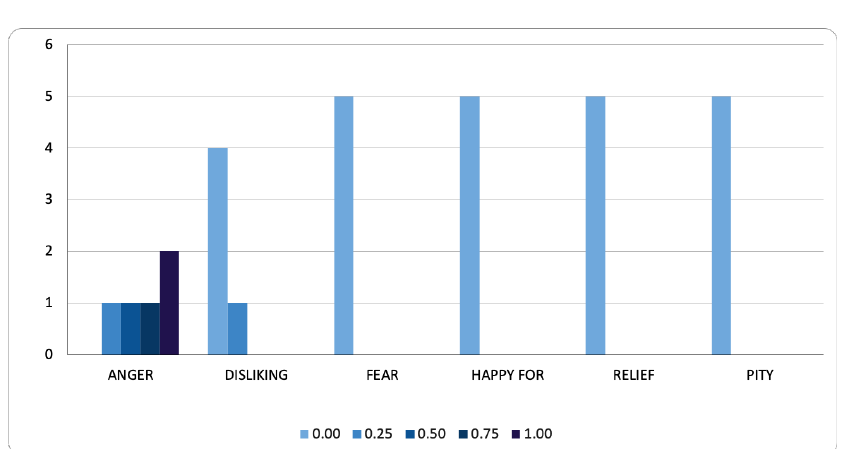
Figure 23. Result Anger.